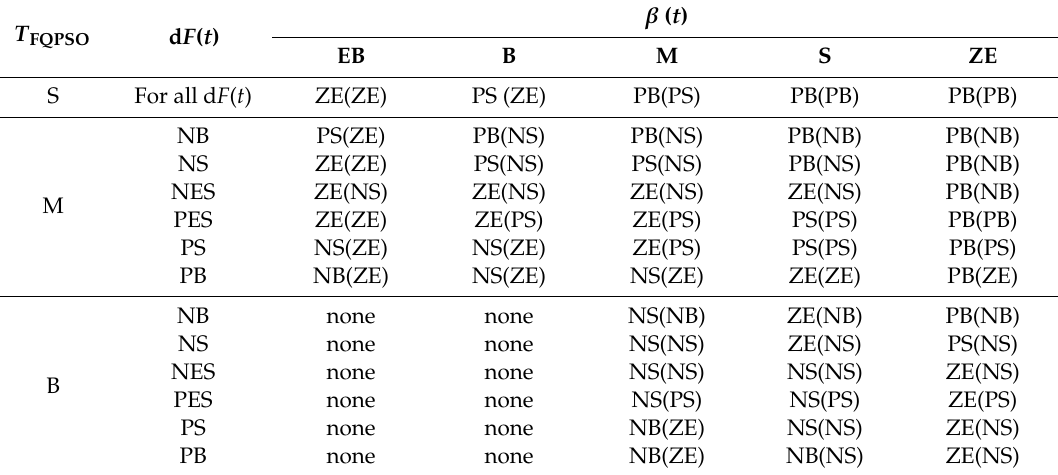
Table 2. Fuzzy rules of d ρ (d α ) For a list of definitions of abbreviations, see Table 3.